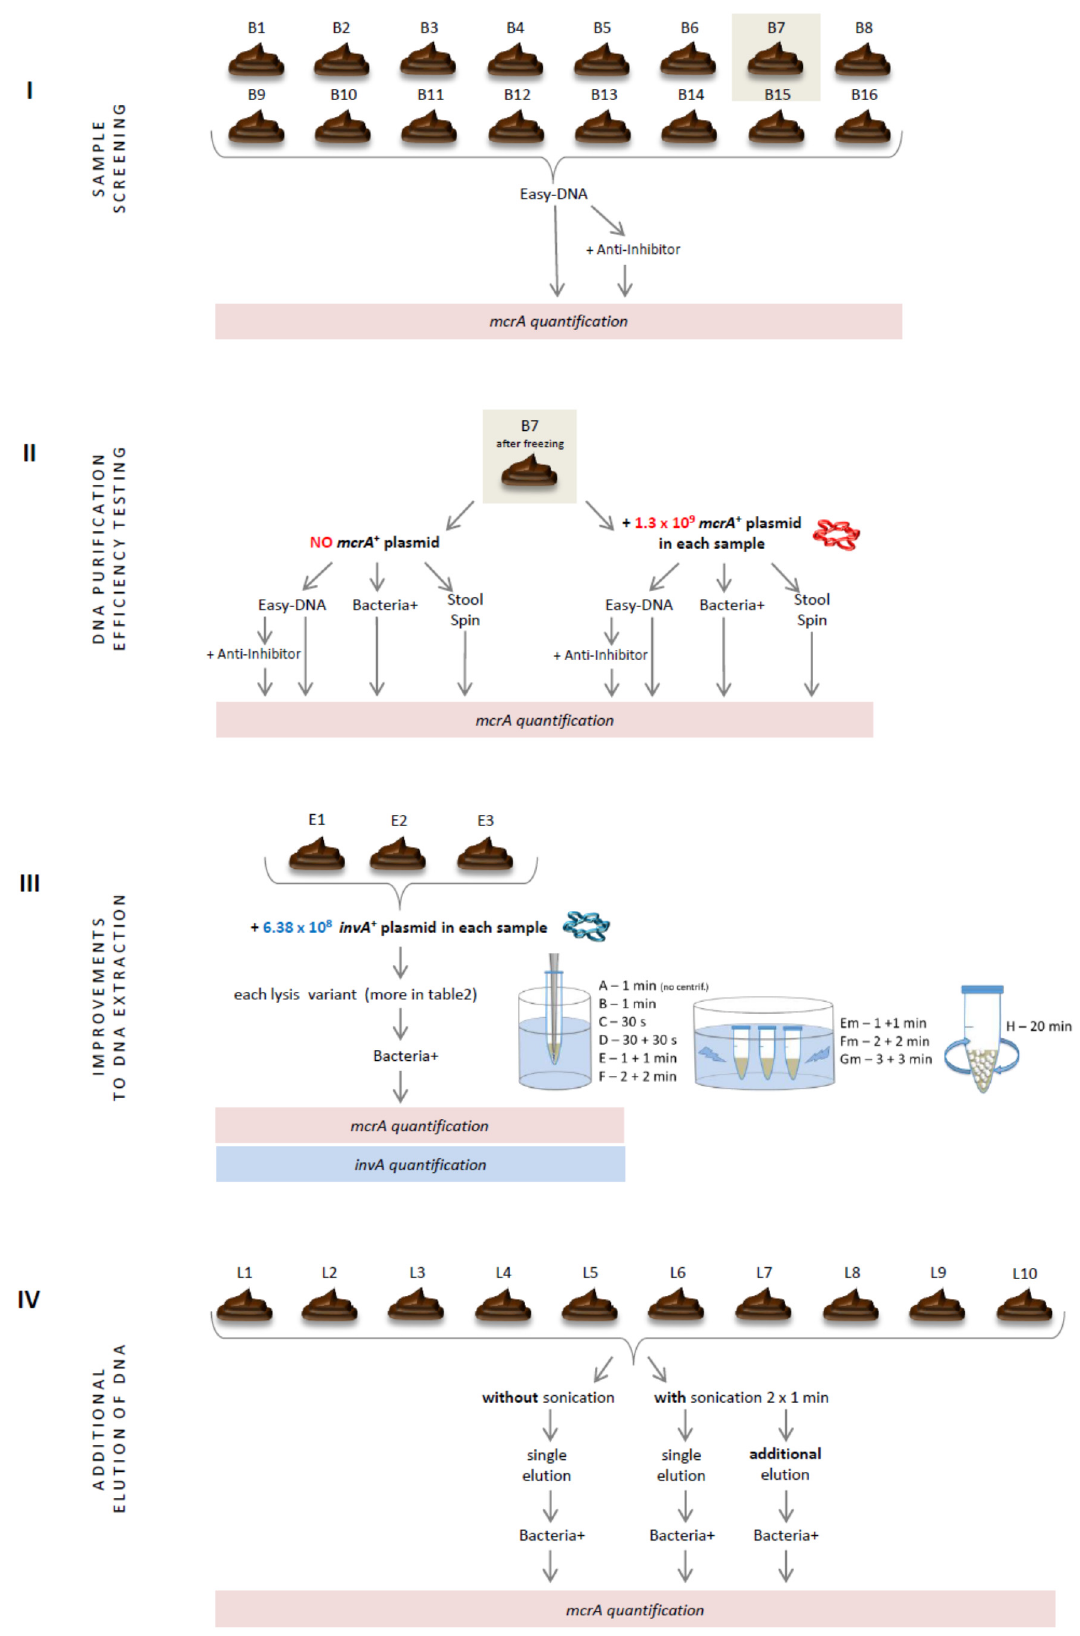
Figure 1. Schematic representation of research.